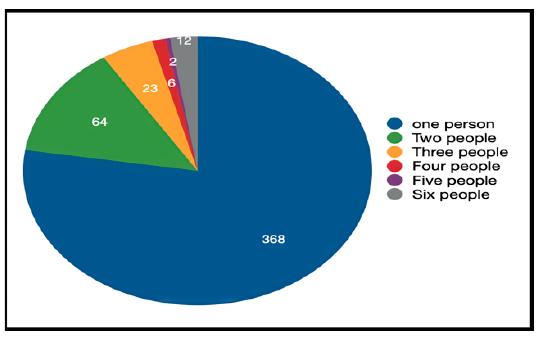
Figure 11. Number of people per image.